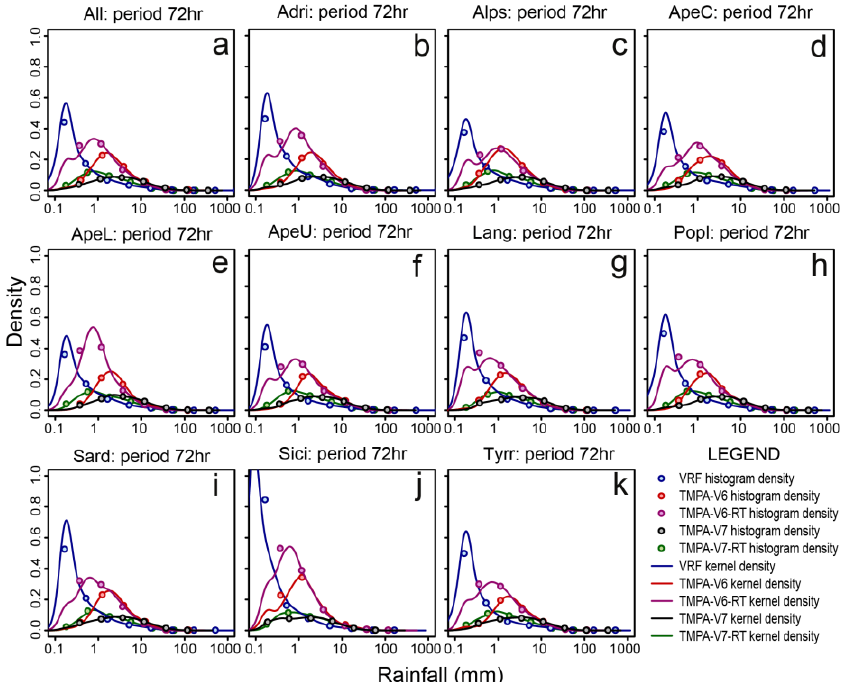
Figure 10. Comparison of the probability density (see Table 5 for Kolmogorov-Smirnov test results) of the logarithm of 72-h cumulative rainfall estimated using HDE (points) and KDE (lines) method for VRF data and for the different satellite rainfall estimates (TMPA-V6, TMPA-V6-RT, TMPA-V7, TMPA-V7-RT) thresholds in the entire Italian territory and in the different morphological subdivisions (see Table 2 and Figure 1). Table 5. Results of bootstrapped Kolmogorov-Smirnov test (hypothesis: greater) comparing the VRF data and the different satellite rainfall estimates (TMPA-V6, TMPA-V6-RT, TMPA-V7, TMPA-V7-RT)